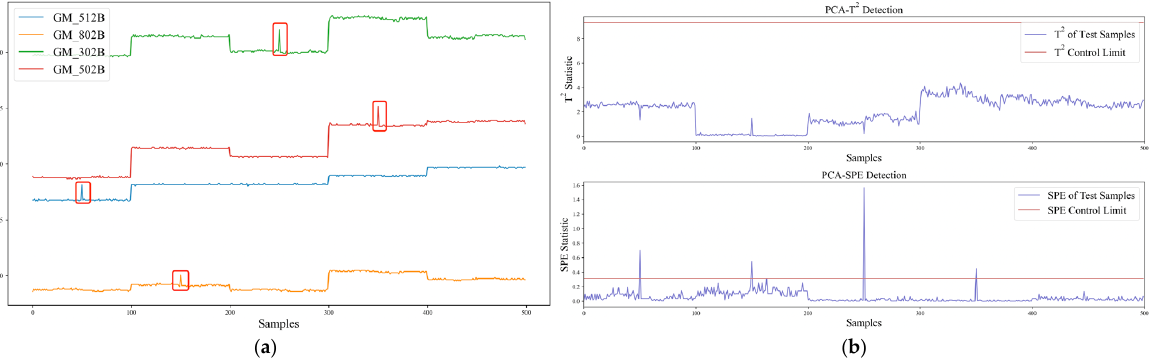
Figure 10. Detection results of transient faults with PCA model: ( a ) Transient Faults of Gas Sensor Array; ( b ) Detection Results of PCA-SPE and PCA-T 2 .